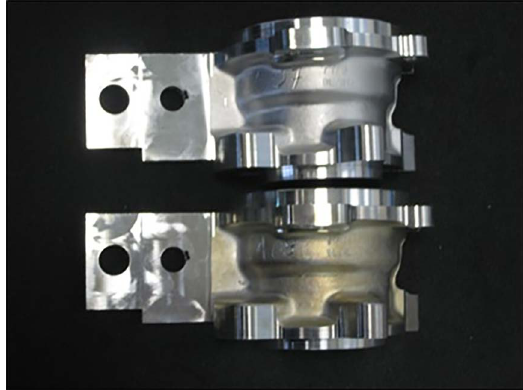
Figure 1. AA7075-T73 parts used in the study Corrosion of the aluminum alloy appeared right after the machining process was finished. Figure 2 shows, as an example, a machined part that presented corroded